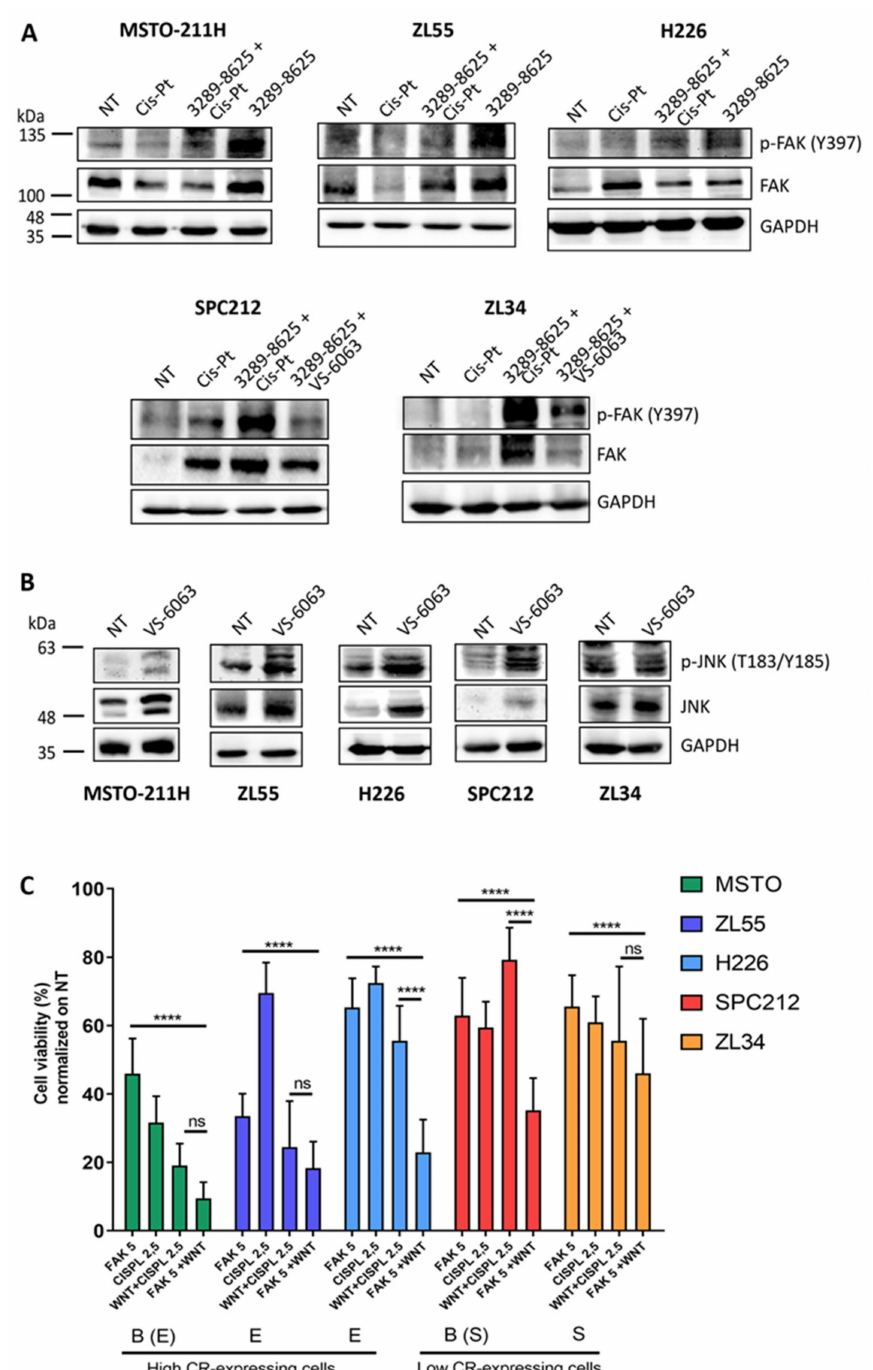
Figure 5. Western blot analysis of proteins implicated in FAK and Wnt signaling pathways in MM cells. ( A ) Western blot analysis of p-FAK (Tyr 397 ) and total FAK after treatment with Cis-Pt (2.5 µ M), 3289-8625 (100 µ M) or the combination of 3289-8625 + Cis-Pt and 3289-8625 + VS-6063. GAPDH was used as loading control. ( B ) Levels of p-JNK (Thr 183 / Tyr 185 ) and total JNK in MM cells treated with VS-6063 (5 µ M). GAPDH was used as loading control ( n = 3 independent experiments). Quantification of p-FAK (Tyr 397 ) and total FAK signals in ( A ) and p-JNK (Thr 183 / Tyr 185 ) and total JNK signals in ( B ) is shown in Figure S3. ( C ) Cell viability of MM cells measured by the MTT assay after 72 h of treatment with the di ff erent compounds. B biphasic, E epithelioid, S sarcomatoid ( n = 5 independent experiments; asterisks represent *** p ≤ 0.001 and **** p ≤